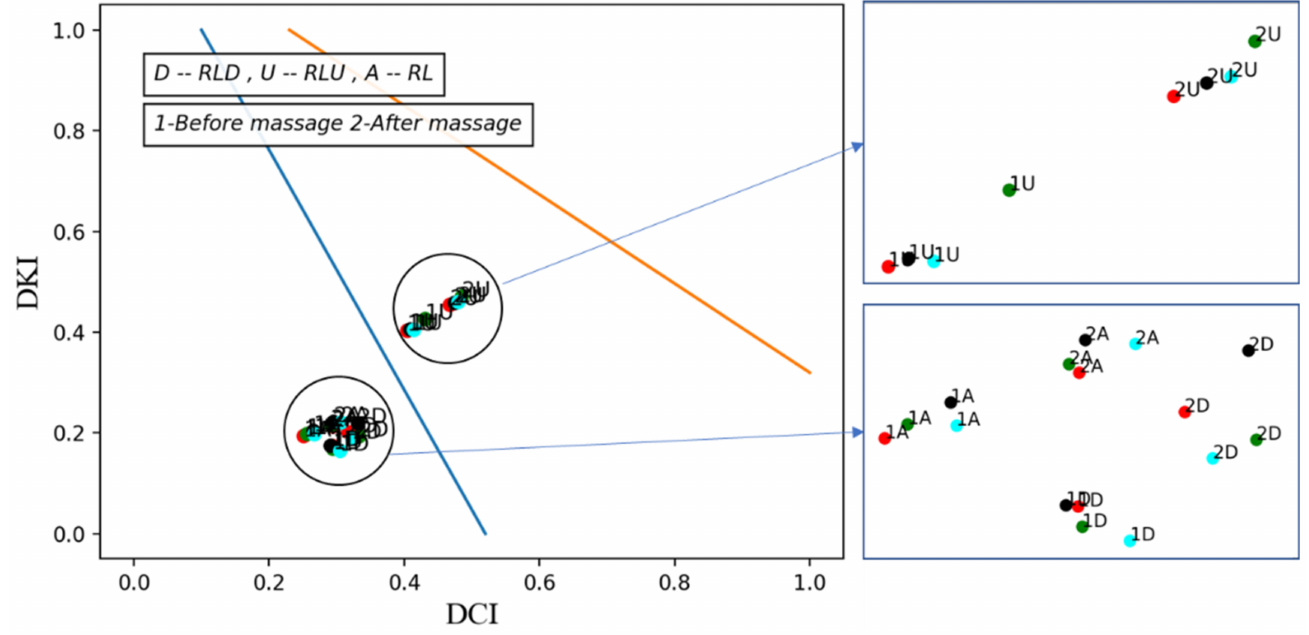
Figure 7. Type of vascular tone of the left leg (massaged) before and after the massage.